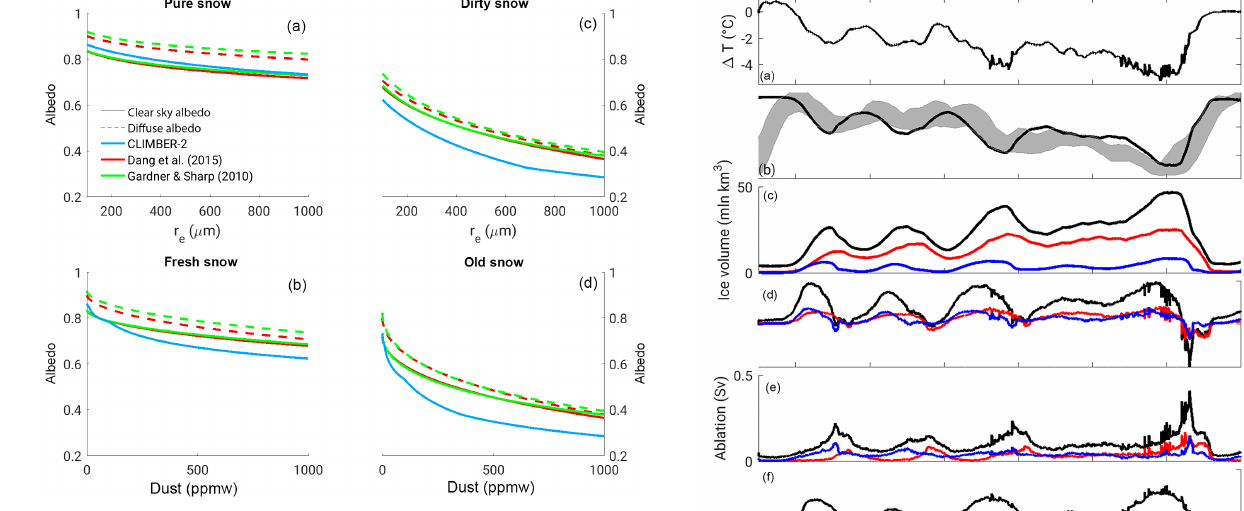
Figure 1. Clear-sky and diffuse snow albedo dependence for a number of different parameterizations (Dang et al., 2015; Gard- ner and Sharp, 2010; Warren and Wiscombe, 1980) as indicated in the legend. (a) Pure snow albedo dependence on effective snow grain radius. (b) Fresh snow albedo ( r e = 100µm) as a function of dust concentration. (c) Dirty snow albedo (dust concentration of 1000ppmw) as a function of snow grain size. (d) Old snow albedo ( r e = 1000µm) as a function of dust concentration. The clear-sky albedo is for a solar zenith angle of 50 ◦ . In CLIMBER-2 the snow albedo for diffuse and direct radiation is identical for solar zenith angles below 60 ◦ .